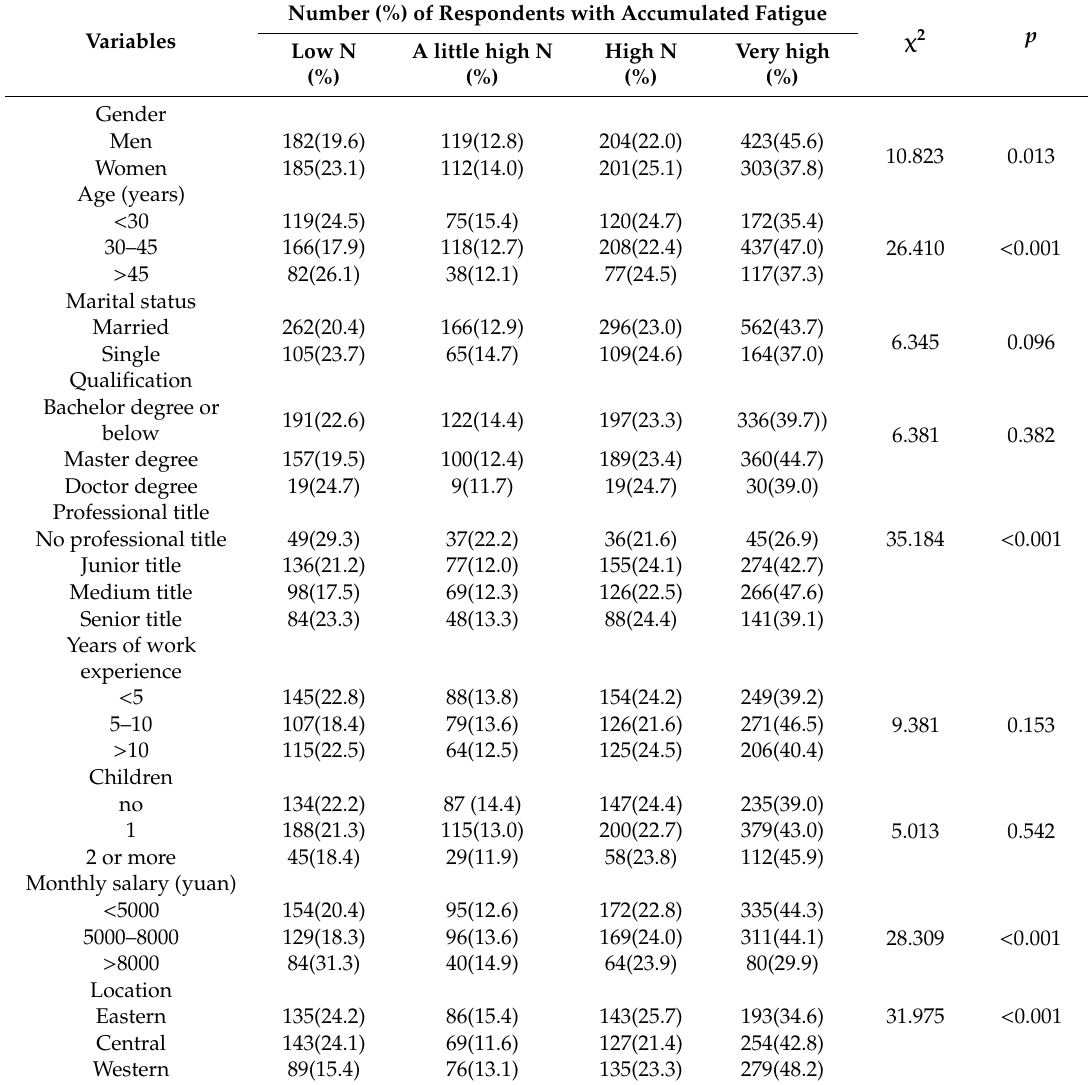
Table 4. Factors associated with work-related accumulated fatigue—results of chi-square